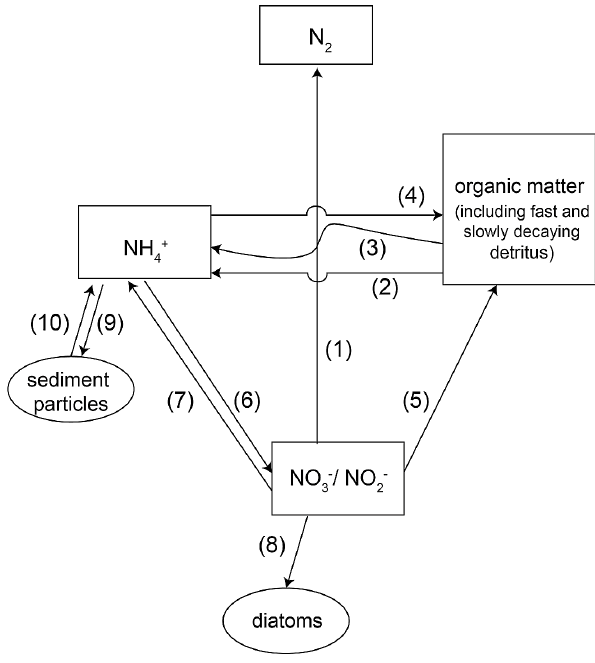
Fig. 2. Conceptual diagram of N fluxes in the N-cycle model. Turnover processes: (1) denitrification; (2) oxic and anoxic mineral- ization; (3) mineralization coupled to denitrification; (4) ammonium assimilation; (5) nitrate assimilation; (6) nitrification; (7) DNRA; (8) nitrate storage in diatoms; (9) ammonium adsorption to parti- cles, (10) desorption of ammonium from particles. Processes 8, 9 and 10 specifically apply to 15 N-labelled pools (see Sect. 2.5 for